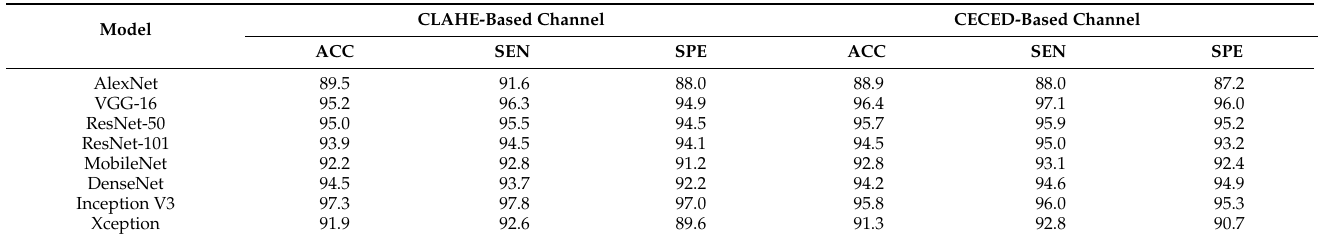
Table 6. Results obtained on the Messidor dataset using different pre-trained models on our pro- posed WFDLN.